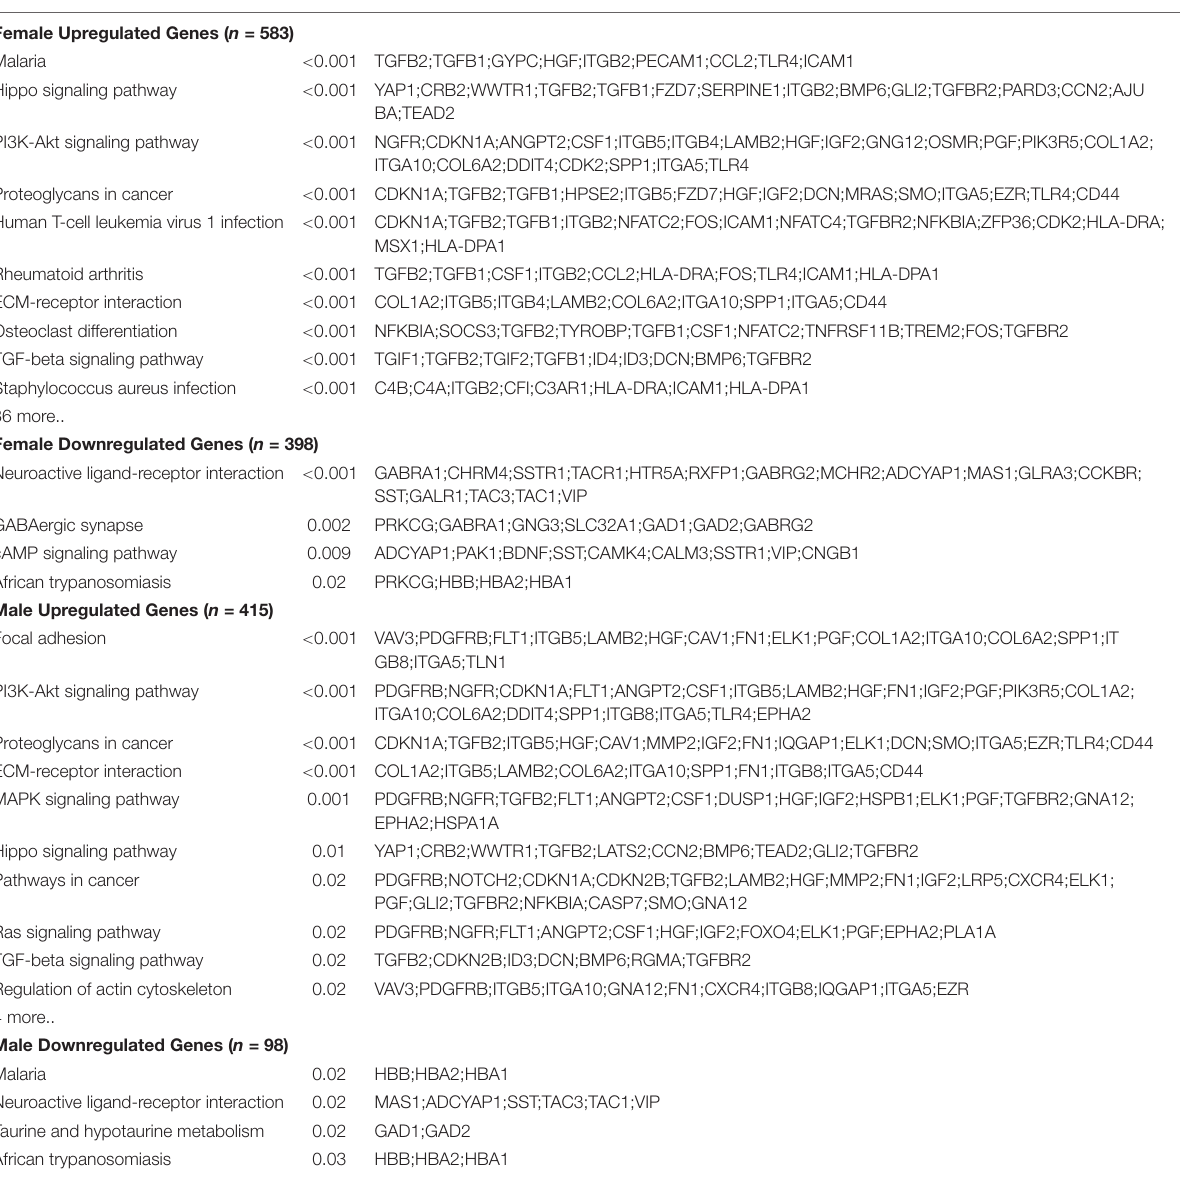
TABLE 2 | Enriched pathways in the brain. Term Adjusted